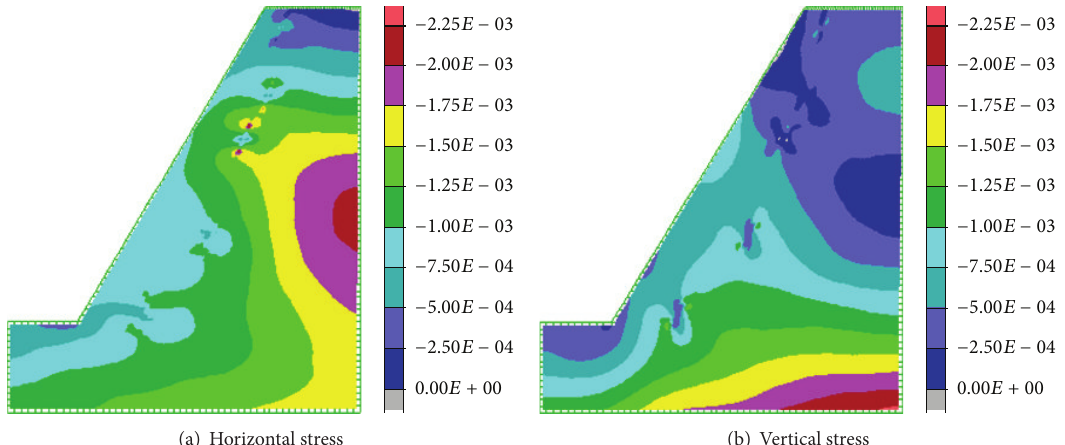
Figure 10: Stress distribution of the rock slope.